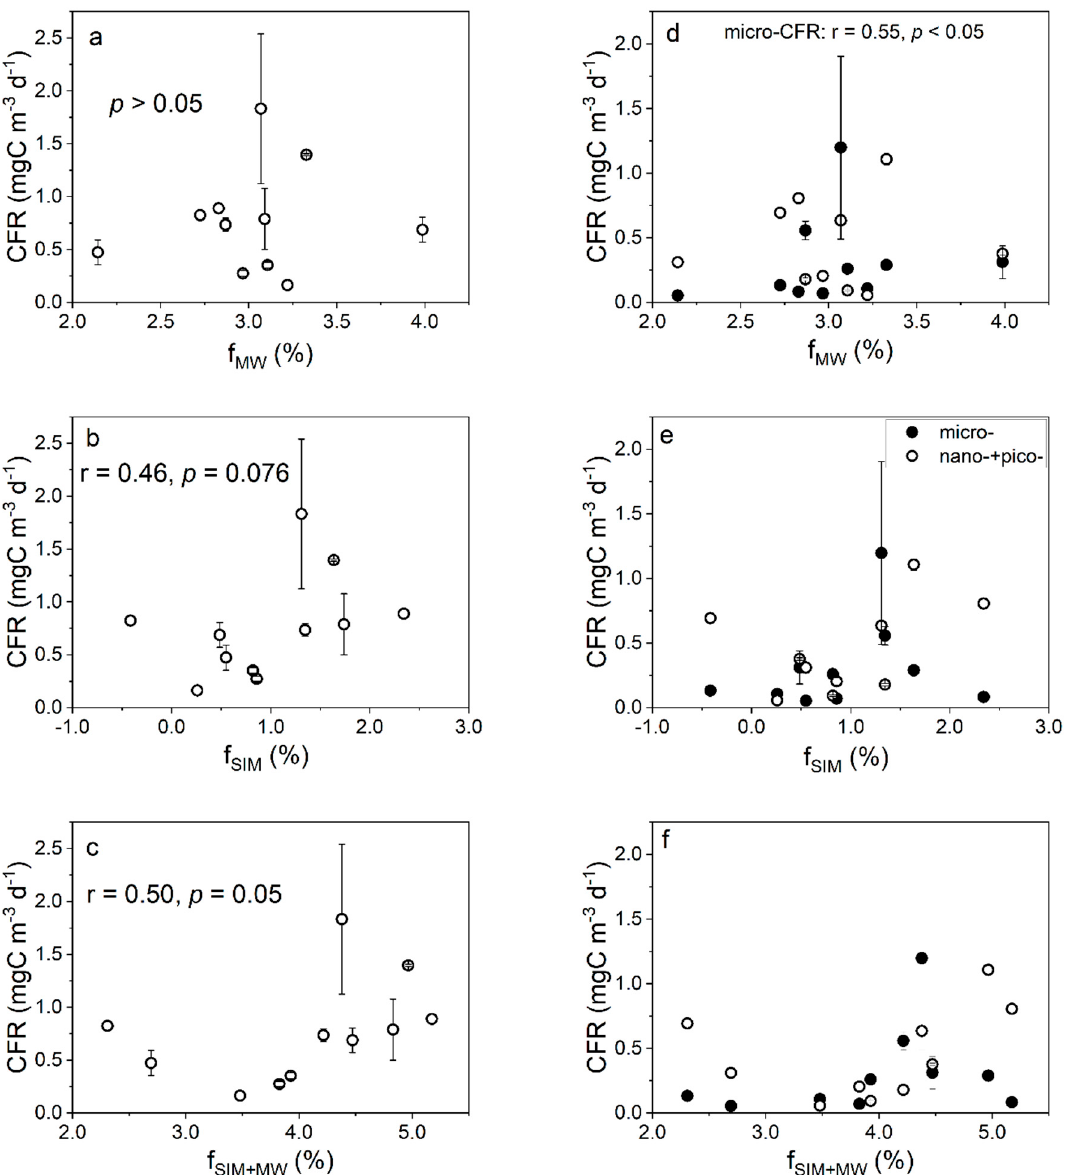
Figure 4. The relationship between the CFR (left panel) and size-fractionated CFR (right panel) values and the f MW ( a , d ), f SIM ( b , e ), and f SIM+MW ( c , f ) values in the surface water. The solid and open circles represent the micro-CFR values and the sum of nano-CFR and pico-CFR values, respectively.